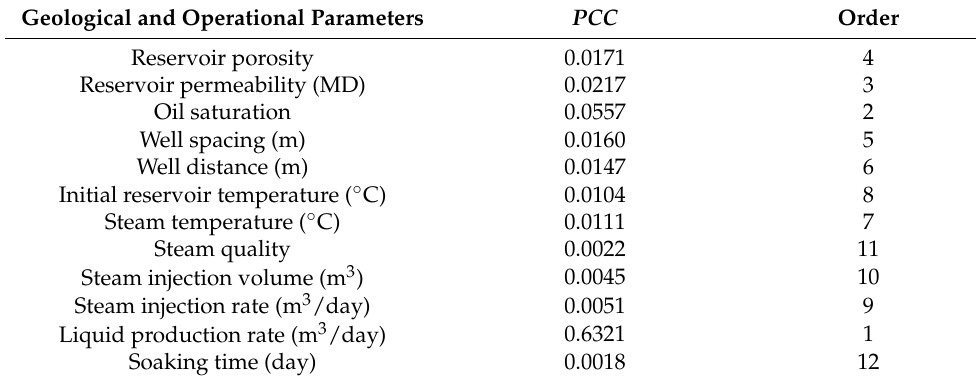
Table 2. The calculated PCC values and the order of the